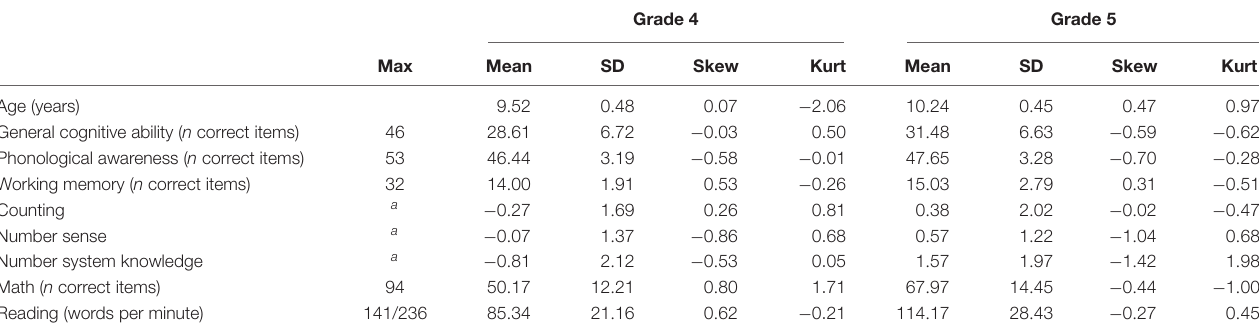
TABLE 1 | Descriptive statistics for grade 4 and grade